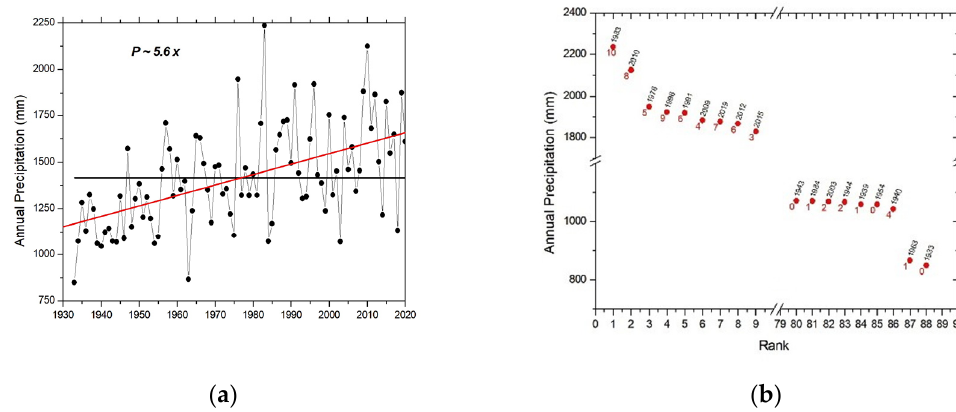
Figure 6. ( a) Total annual precipitation in the MRSP. The black line is the average obtained from all datasets, while the red line is the linear trend. ( b ) Highest and lowest tenth percentiles (red dots) of the annual precipitation in the time series. The attached labels show the year of the precipitation and the number of days with precipitation higher than 50 mm.